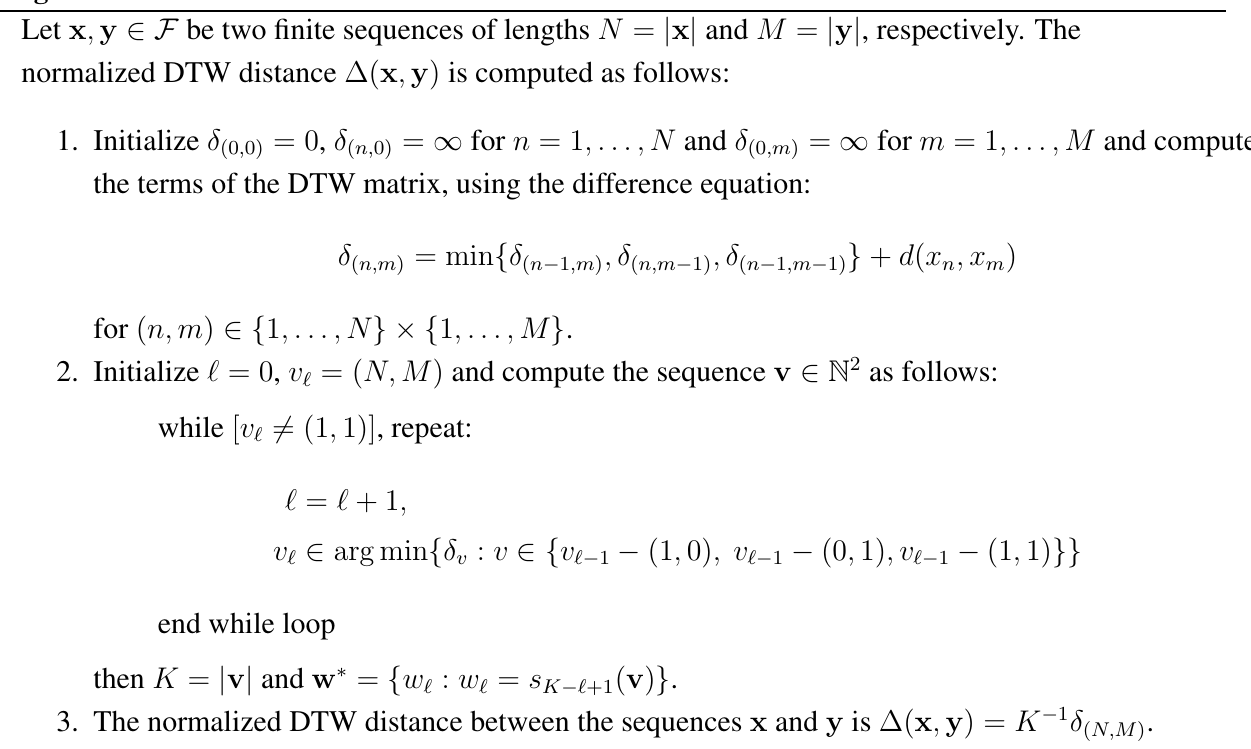
Algorithm 1. Normalized DTW